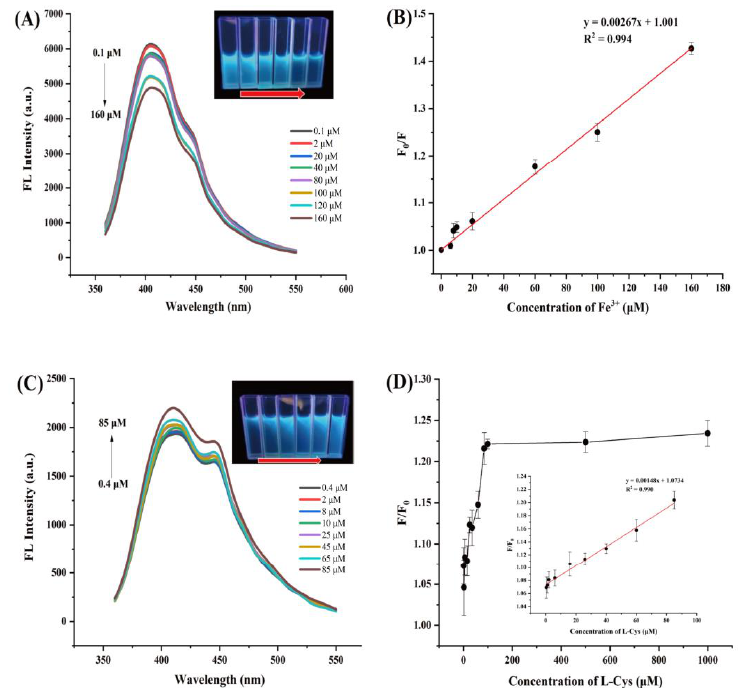
Figure 3. ( A ) Fluorescence spectra of CQDs (0.01 mg/mL) with various Fe 3+ concentrations of 0.1 – 160 µM. Insert: photograph of CQDs with Fe 3+ solutions under UV light (concentrations of Fe 3+ are 0.1, 6, 10, 20, 100, and 160 μM; follow red arrow). ( B ) Relationship of F 0 /F and Fe 3+ concentration. ( C ) Fluorescence spectra of CQDs/Fe 3+ systems of different concentrations of L-Cys. Insert: image of CQDs/Fe 3+ aqueous solutions treated with different concentrations of L-Cys under UV light (concentrations of L-Cys are 0.4, 6, 16, 26, 40, and 85 µM; follow red arrow). ( D ) Relationship of F 0 /F and L-Cys concentration. Insert: Linear relationship between F 0 /F of CQDs and concentration of L-Cys from 0.4 µM to 85 µM.